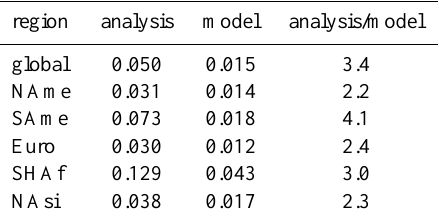
Fig. 8. Average distribution of the sum of the aerosol optical depths (AODs) at 550nm of black carbon and organic matter (OM+BC) during 15July–31December 2010 in the analysis (top), the model (middle) and the model enhanced by a factor 3.4 (bot- tom). (ECMWF experiment IDs fi92 and fi93) Table 6. Regional average sums of the aerosol optical depths at 550nm of black carbon and organic matter during 15July– 31December 2010 in the analysis and the model. The ratio of the two values is also